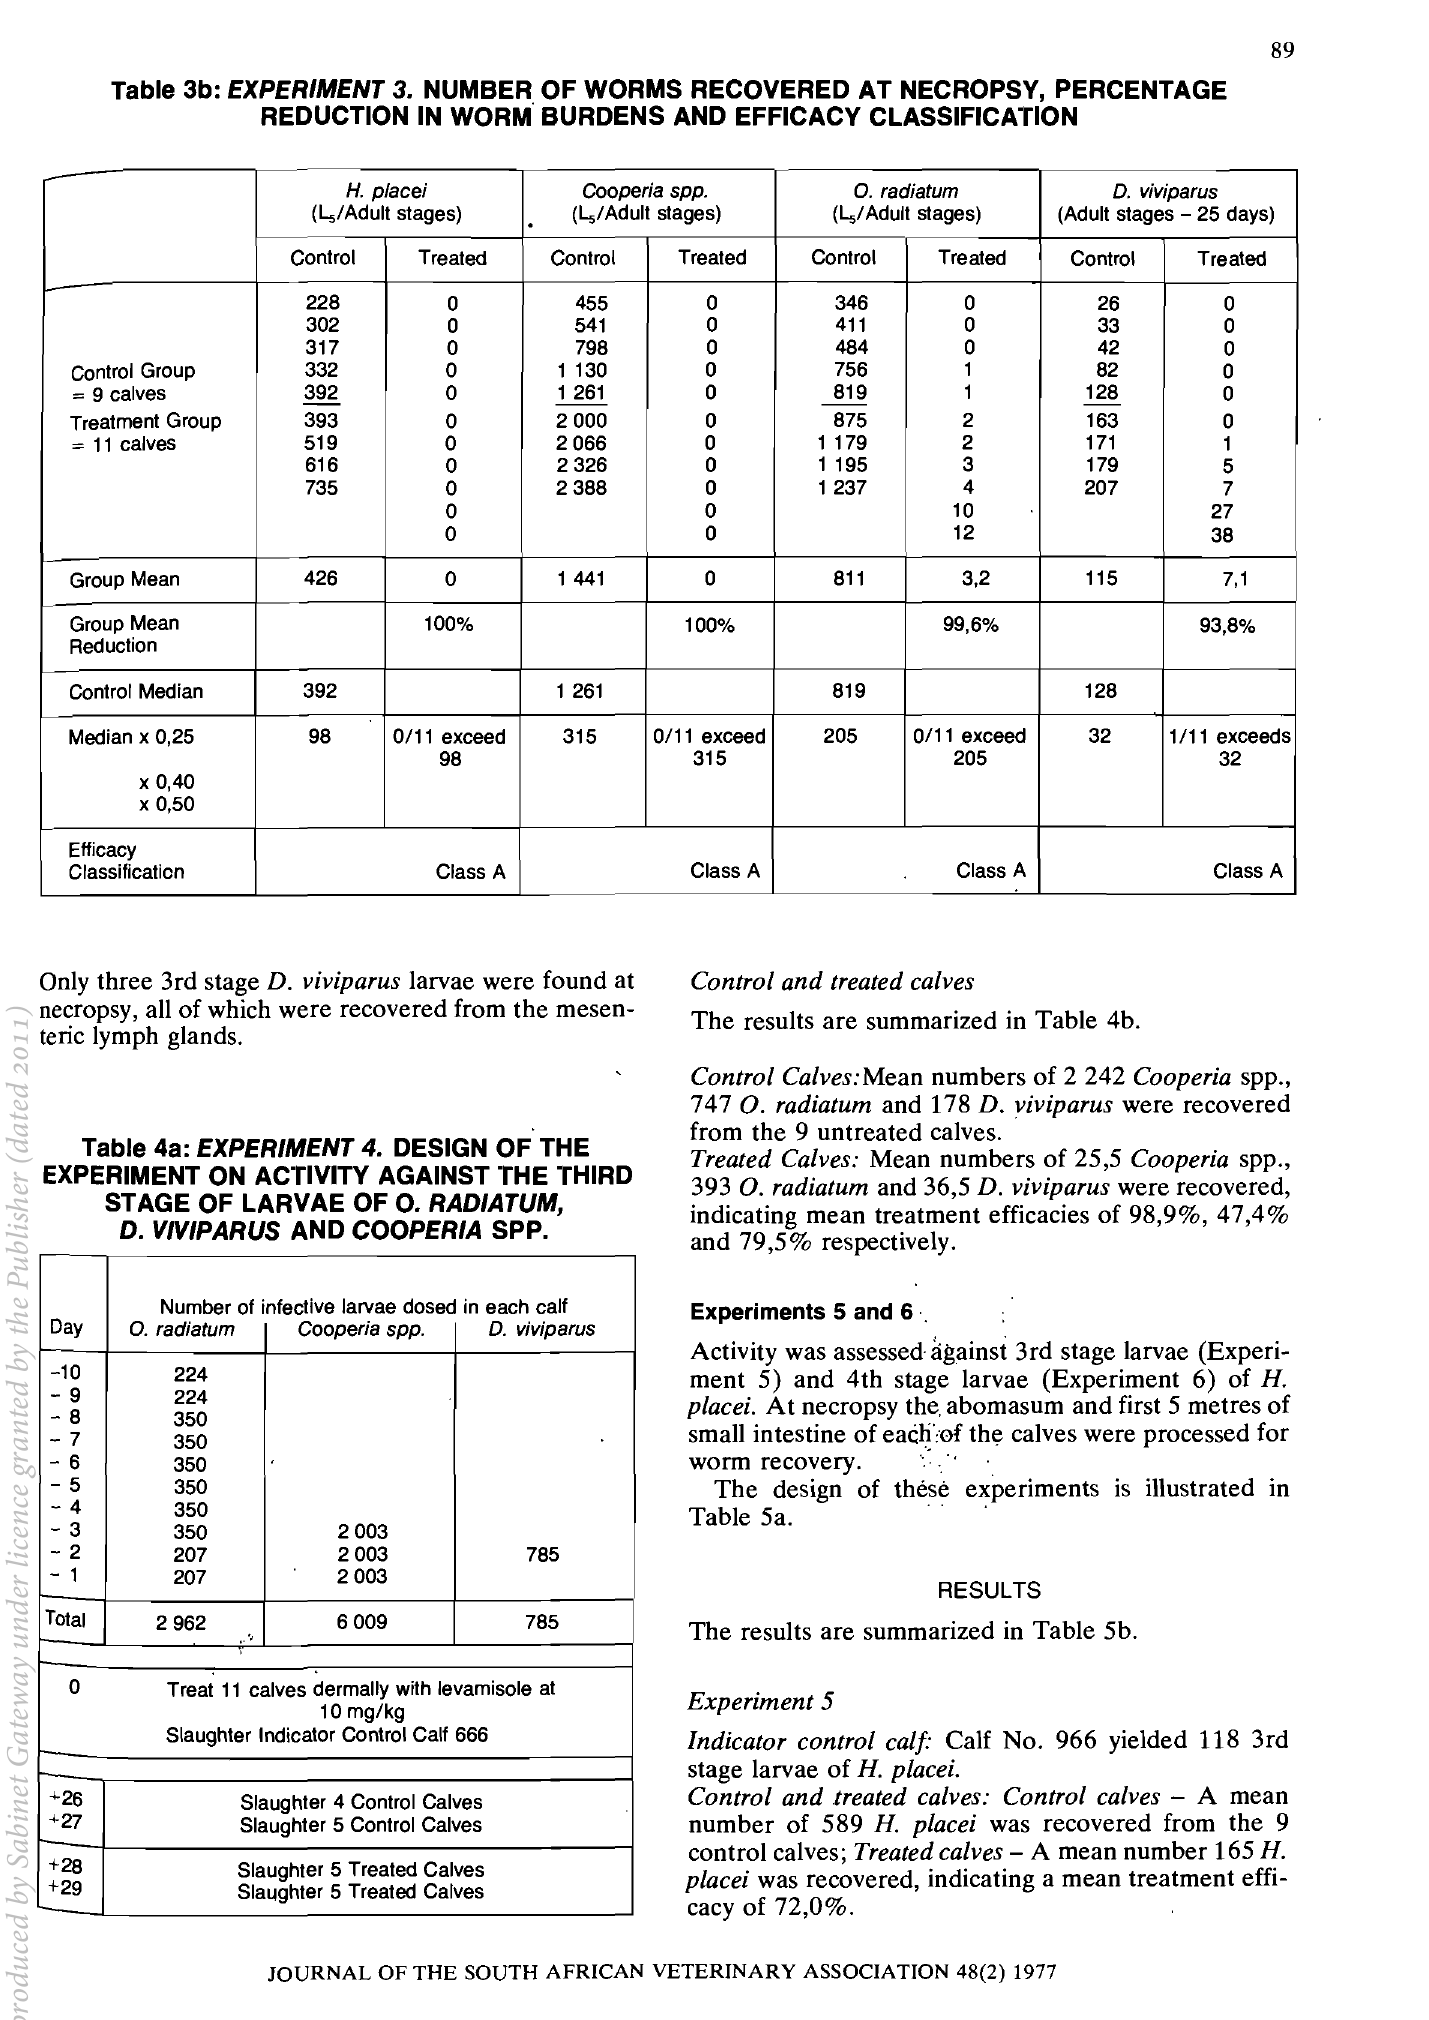
Table 3b: EXPERIMENT 3. NUMBER OF WORMS RECOVERED AT NECROPSY, PERCENTAGE REDUCTION IN WORM BURDENS AND EFFICACY CLASSIFICA'nON -